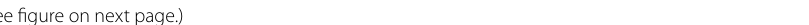
strategies(See figure on next Fig. 6 Immunomodulation and immunotherapeutic strategies of MSCs in liver diseases. Due to the immunomodulatory plasticity of MSCs and their ability to deliver immunomodulators after modification, MSCs can exert immunosuppressive effects in inflammatory liver diseases including ( a ) Cirrhosis, ( b ) AIH, ( c ) AVH, ( d ) AH and ( e ) NASH, thereby ameliorating immune‑mediated liver injury, liver inflammation and fibrosis. The dashed arrows indicate potential immunomodulatory mechanisms or immunotherapeutic